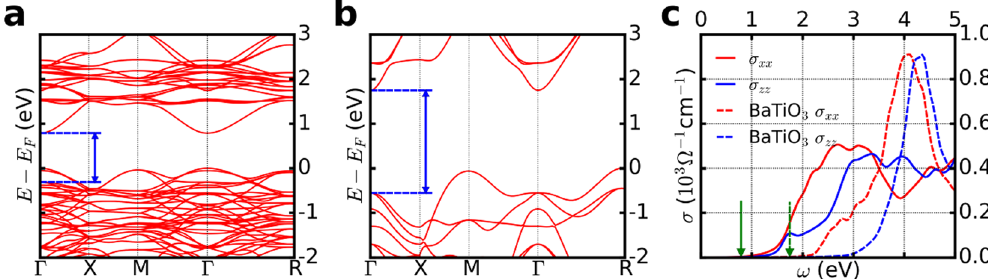
Figure 2. Comparison of band structure and optical conductivity between Ba 2 VFeO 6 and BaTiO 3 . The results for Ba 2 VFeO 6 are calculated using DFT-PBE + U + J method. The results for BaTiO 3 are calculated using DFT- PBE method. ( a ) Band structure of tetragonal Ba 2 VFeO 6 . The blue arrow indicates the threshold of optical transition. ( b ) Band structure of tetragonal BaTiO 3 . The blue arrow indicates the threshold of optical transition. ( c ) Optical conductivity σ of tetragonal Ba 2 VFeO 6 (solid lines) and tetragonal BaTiO 3 (dashed lines). The red lines are for the xx -component and the blue lines are for the zz -component. The green arrows indicate the fundamental gap of band structures.